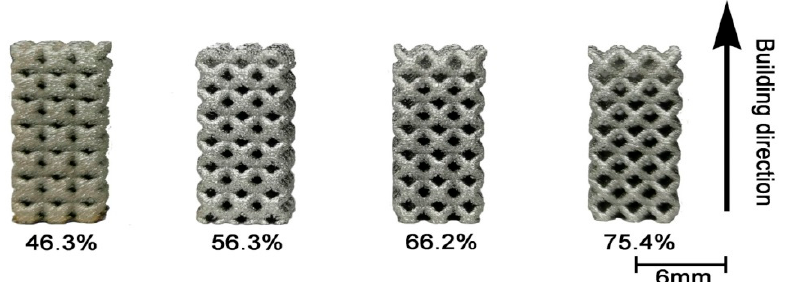
Figure 3. The as-built Ti64 samples with different porosity designs.